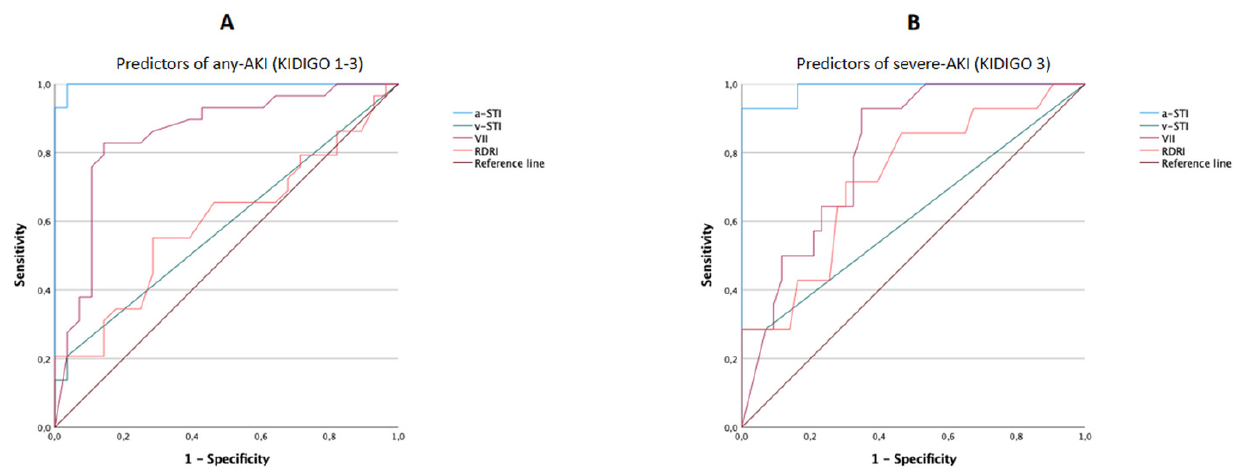
Figure 5. Receiver operator characteristic (ROC) curves for arterial systolic time intervals (a-STI), renal Doppler resistive index (RDRI), venous systolic time intervals (v-STI), venous impedence index (VII) as putative predictors for any acute kidney injury (AKI) (panel ( A )) or severe AKI (panel ( B )).